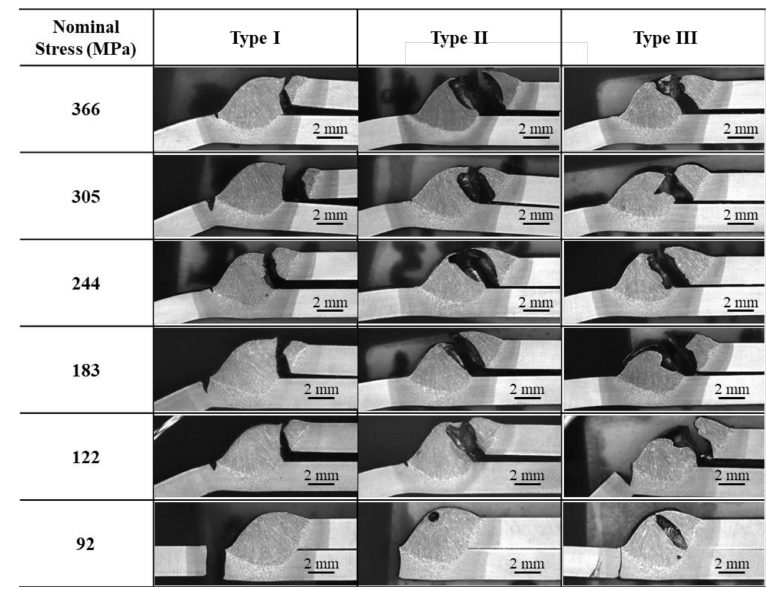
Figure 13. Fatigue fracture with various nominal stresses and weld